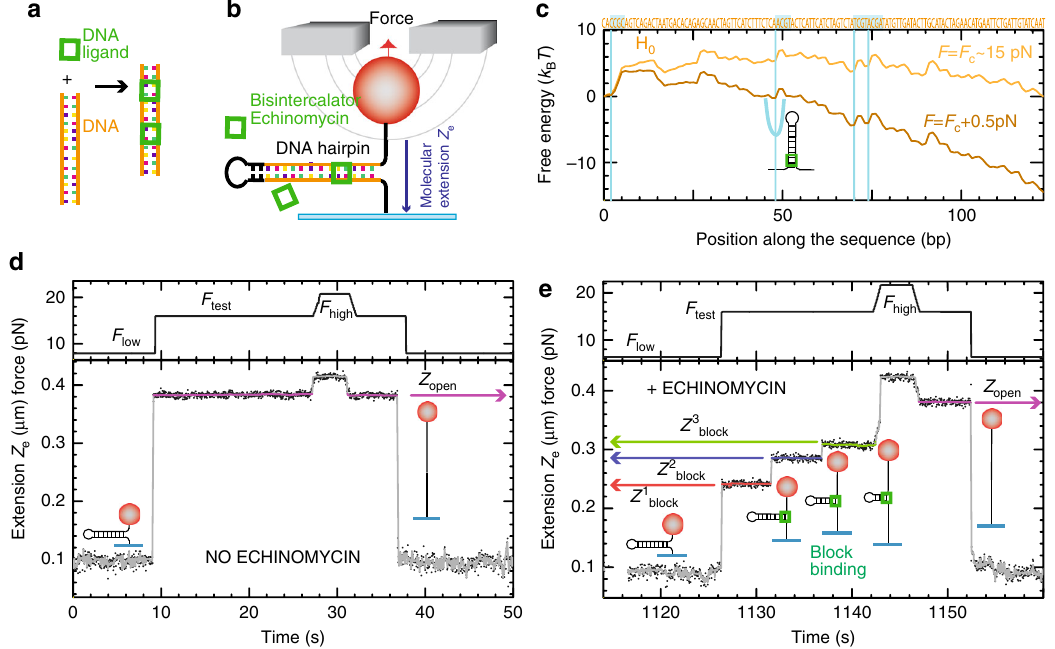
Fig. 1 High-throughput footprinting assay using magnetic tweezers. a Schematics of the ligand binding to DNA. b Schematics of the magnetic tweezers experimental set-up. c Free energy landscape of hairpin H 0 at the coexistence force ( F c = 15 pN) in yellow and at a larger force ( F c + 0.5 pN) in brown . The H 0 sequence is shown in the upper part and the tetranucleotide XCGY motifs, that are the preferred Echinomycin binding sites, are highlighted in blue. d Experimental trace Z e ( t ) obtained with H 0 when applying a FC protocol, showing the unzipping and rezipping of the hairpin (lower panel). The FC protocol consists in the alternation of three different forces: F low , F test , and F high ( upper panel ). e Experimental trace Z e ( t ) obtained with H 0 in presence of [Echinomycin] = 300 nM ( lower panel ) when applying a FC protocol ( upper panel ), showing the three different binding events during the hairpin unzipping ( Z 1 ; 2 ; 3 , red , blue , green respectively). The extension of the fully unfolded state at the same force F test is also measured ( Z open , purple block